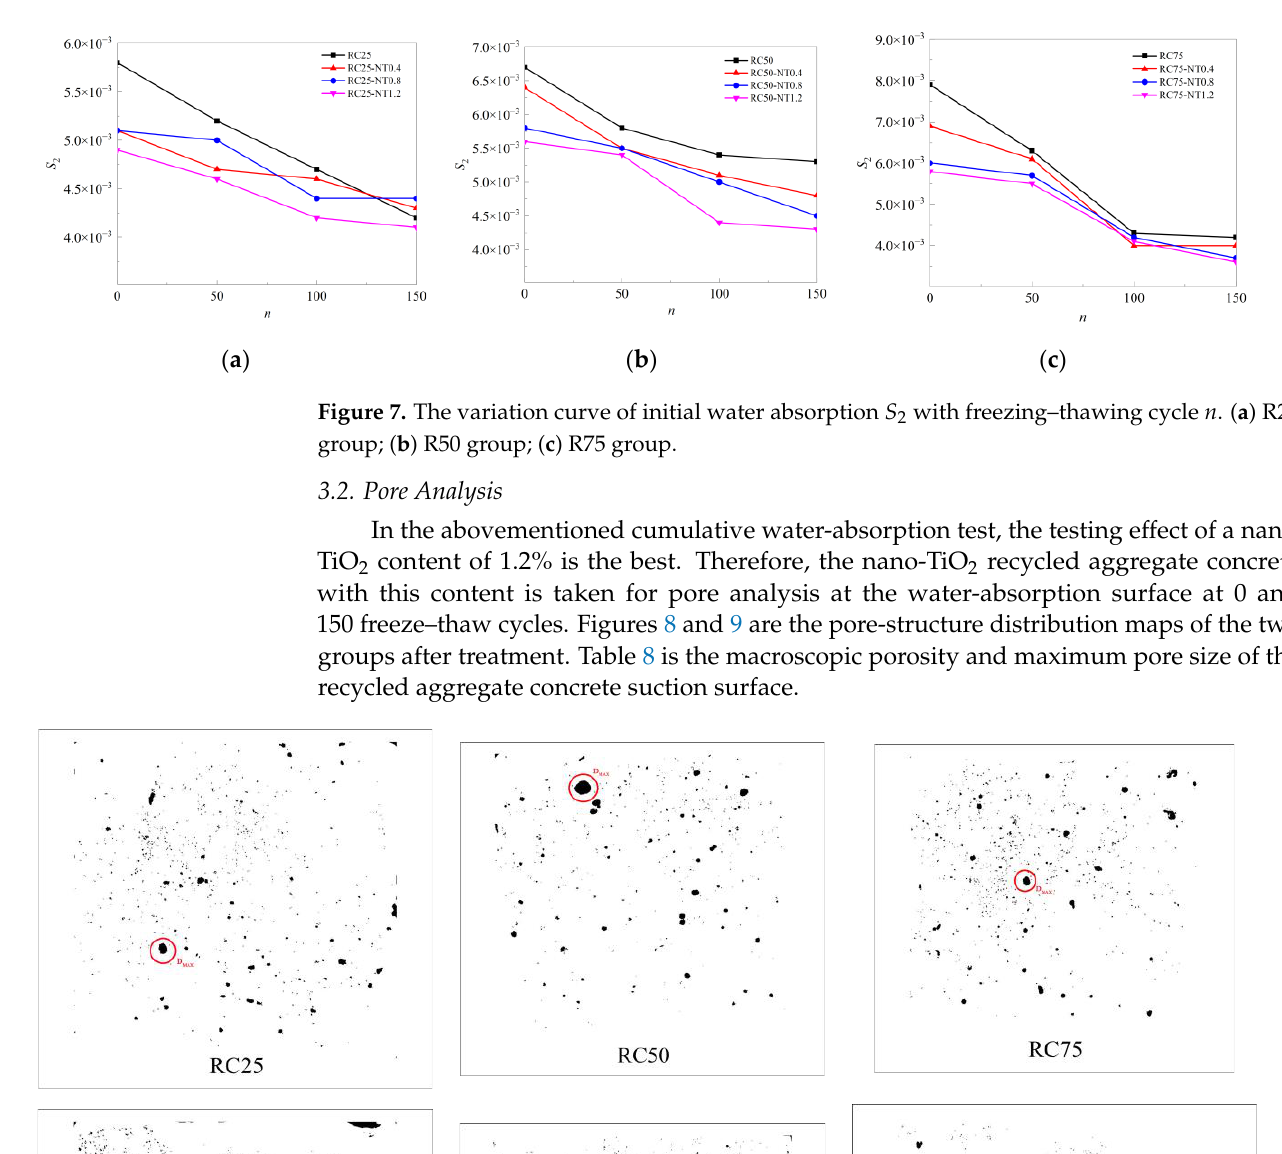
Figure 9. Macroscopic pore diagram of recycled aggregate concrete at 150 freeze – thaw cycles.